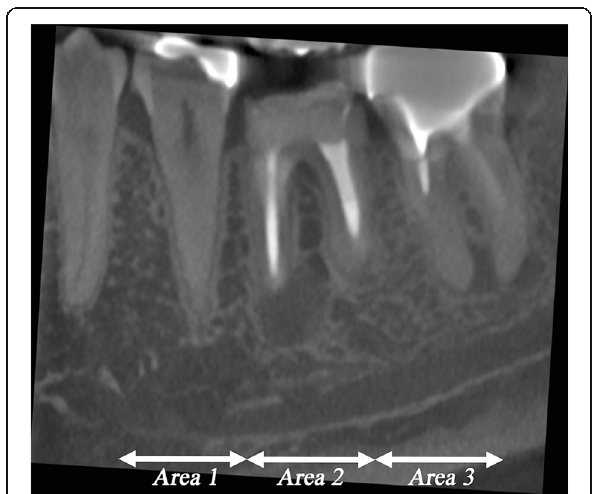
Fig. 1 Cross-sectional images in the range of 30 mm just distal to the mental foramen were used for evaluation. The range was divided into three areas, each of which was 10 mm in length, designated as area 1, area 2, and area 3, from anterior to